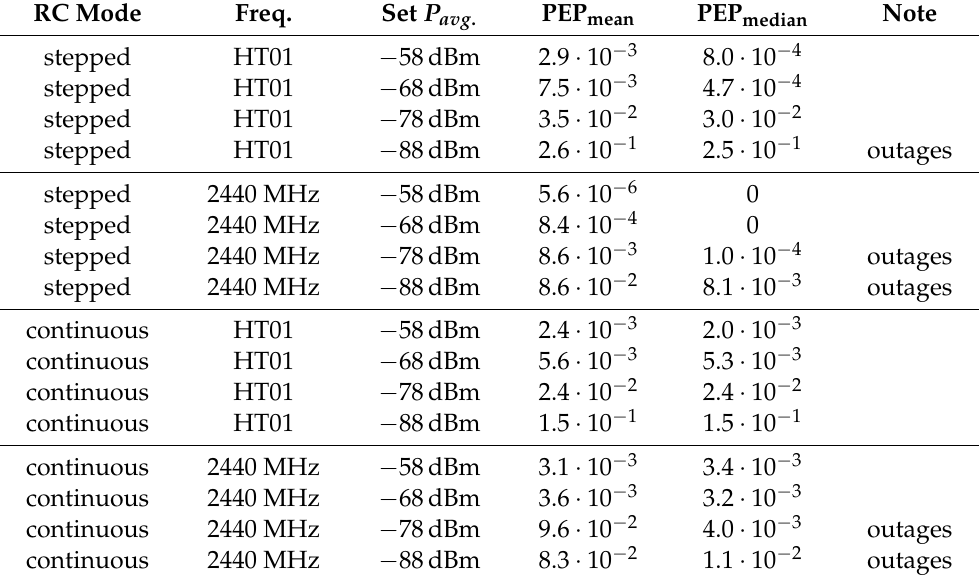
Table 5. Results of the MCPE